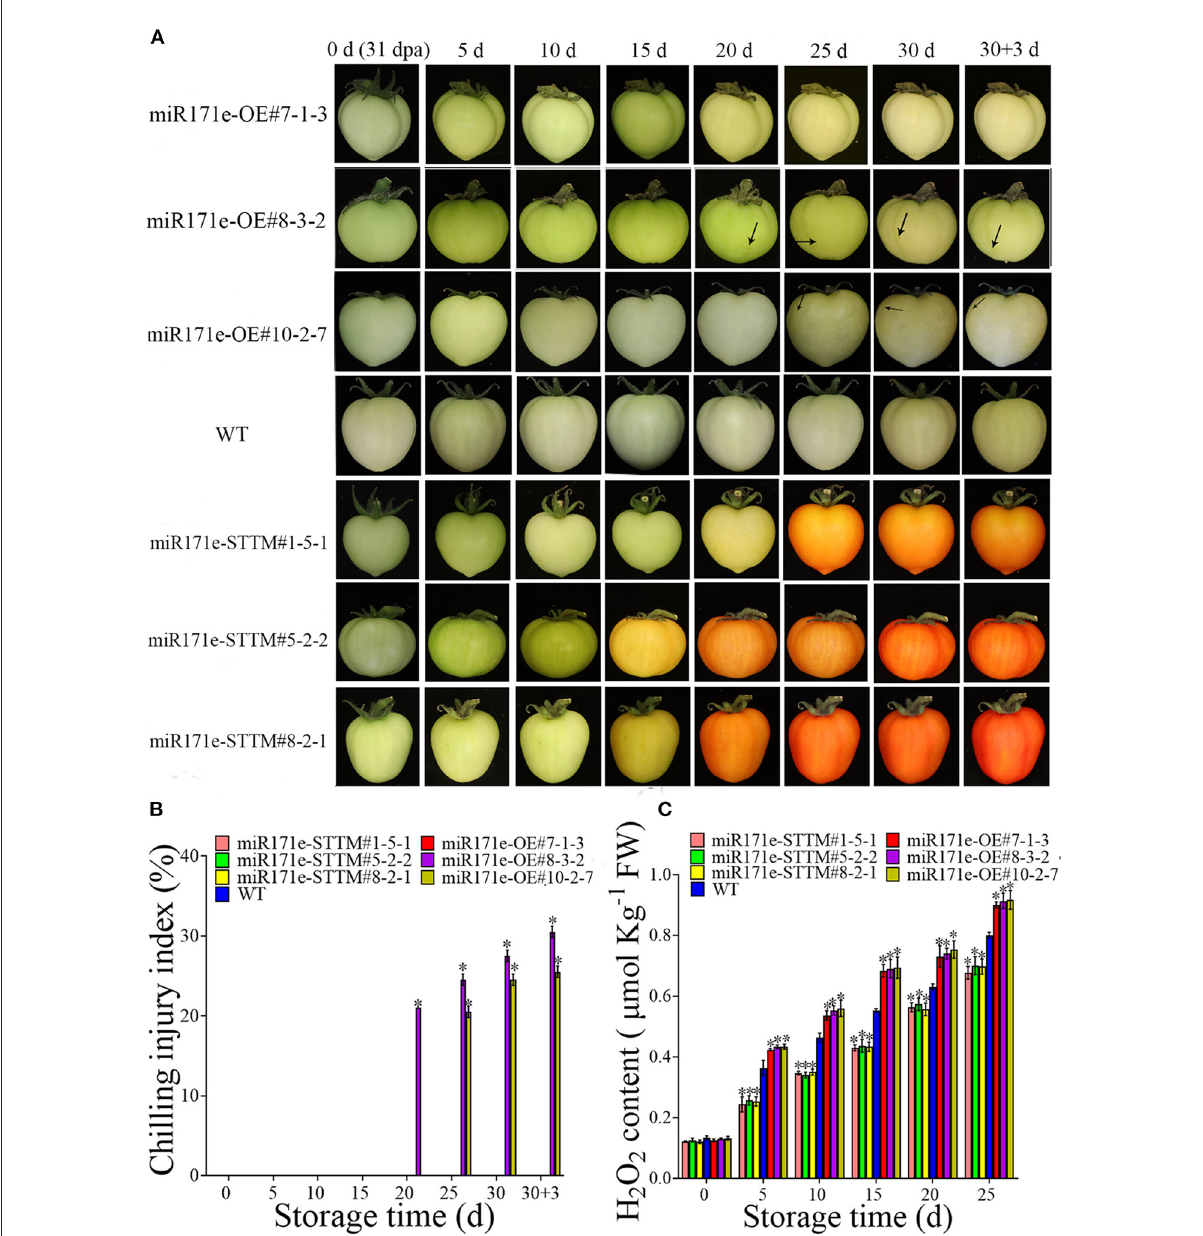
FIGURE2 The CI and phenotypic characterization in tomato fruit at MG stage. (A) The H 2 O 2 content of tomato fruit at MG stage. (B) The CI index of tomato fruit at MG stage. (C) . Vertical bars represent standard deviations of the means, n = 3. Asterisks indicate the statistical difference in the significance at * p <